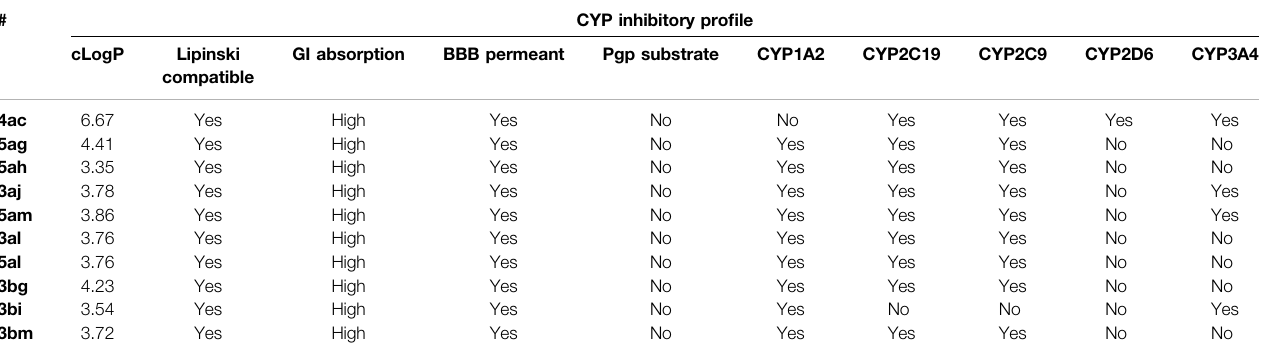
TABLE 6 | Pharmacokinetic parameter values of interest.